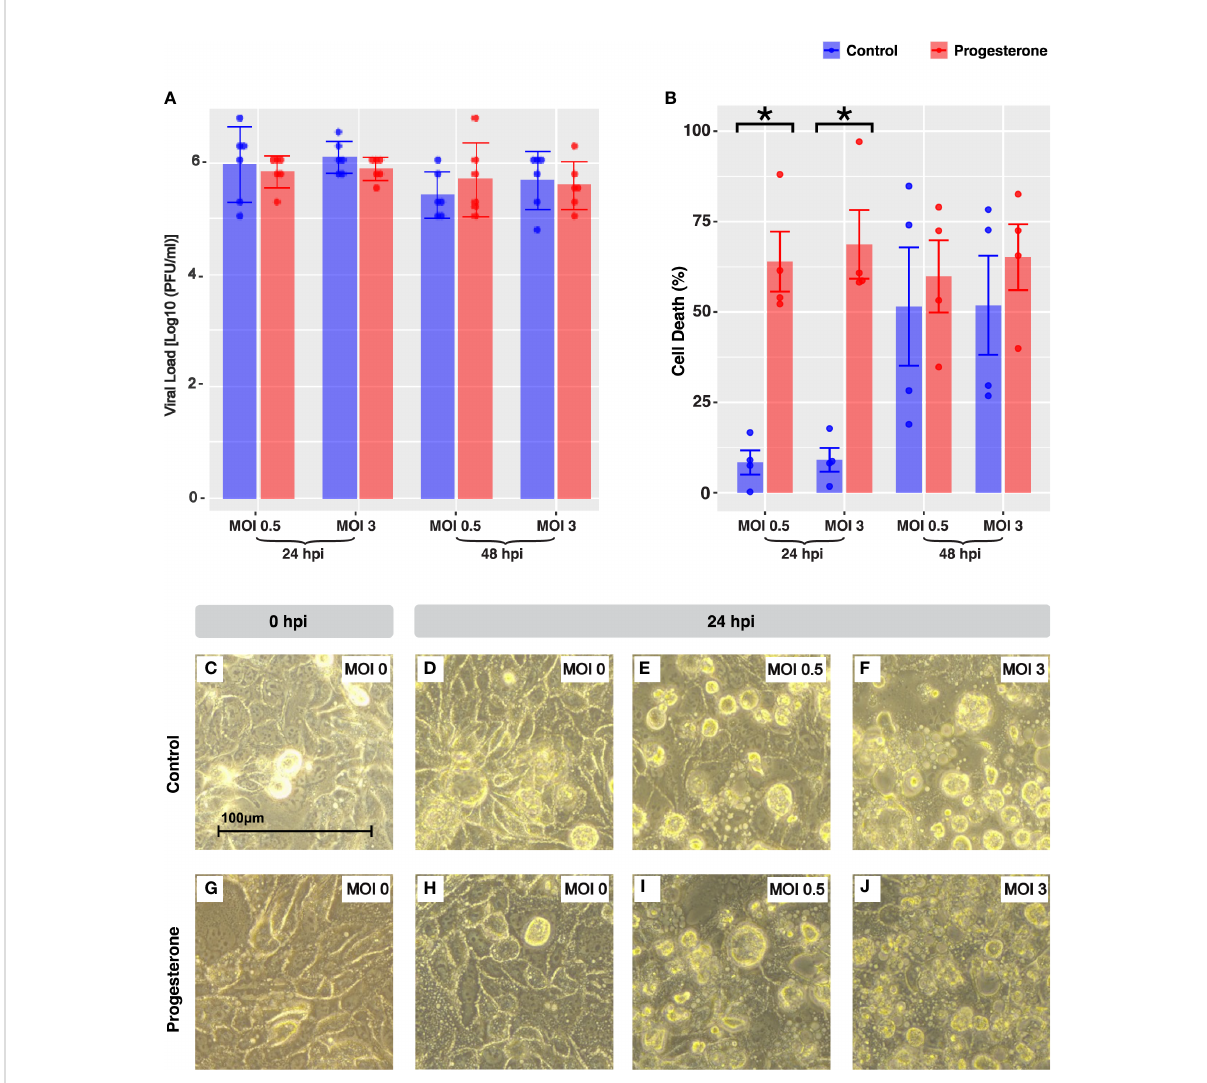
FIGURE 1 Cell death and cytopathic effect in Calu-3, a lung cell line. IAV viral load is shown in Calu-3 (A) . The bar plot depicts the Log10(PFU/ml) value grouped by MOI and time point. Cell death was quanti fi ed by LDH release in a subset of the experiments shown in panel A (B) . Microscope images (40X objective lens) captured representative cellular pathology in control (C – F) and progesterone-treated Calu-3 cells (G – J) at 24 hours post-infection, the timepoint at which there was a signi fi cant increase in cell death due to progesterone treatment. The cells at 0 hours post- infection were infected with MOI 0 (C, G) . At 24 hours post-infection, cells are shown infected with MOI 0 (D, H) , MOI 0.5 (E, I) , and MOI 3 (F, J) . Blue indicates control cell lines and red indicates progesterone-treated cell lines. *p-value was less than 0.05, as determined by the statistical analysis detailed in the Methods